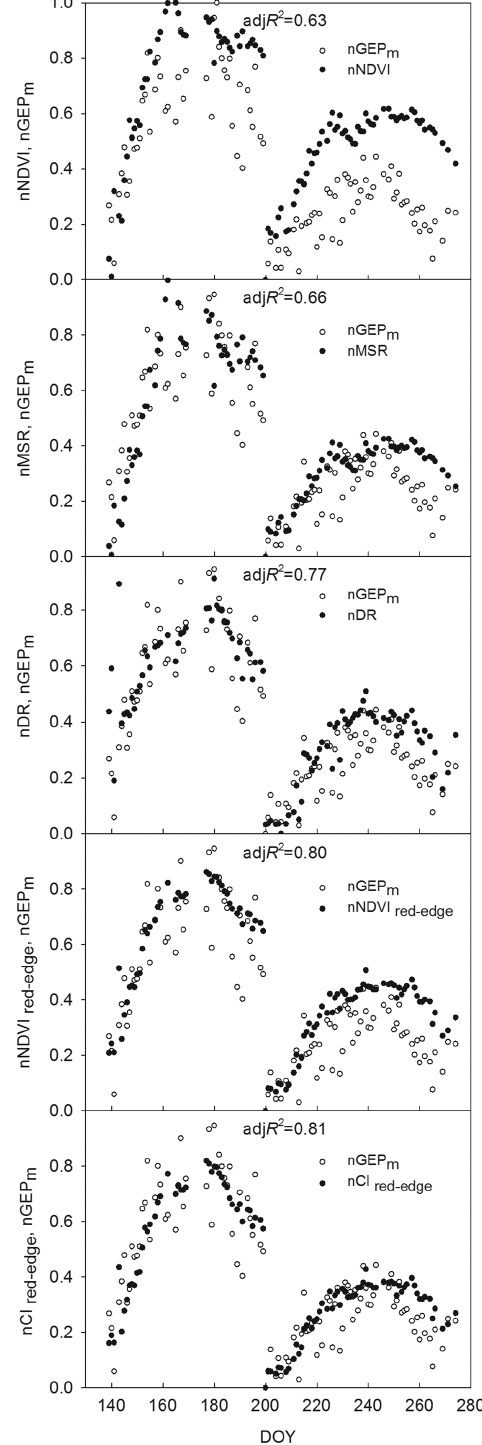
Figure 3. Seasonal courses of normalized spectral vegetation in- dices – nVIs (–) and normalized mean midday gross ecosystem pro- duction – nGEP m (–) in the growing season of 2012; adj R 2 between GEP m estimated from EC measurements and GEP m obtained with model 1 fed with the various